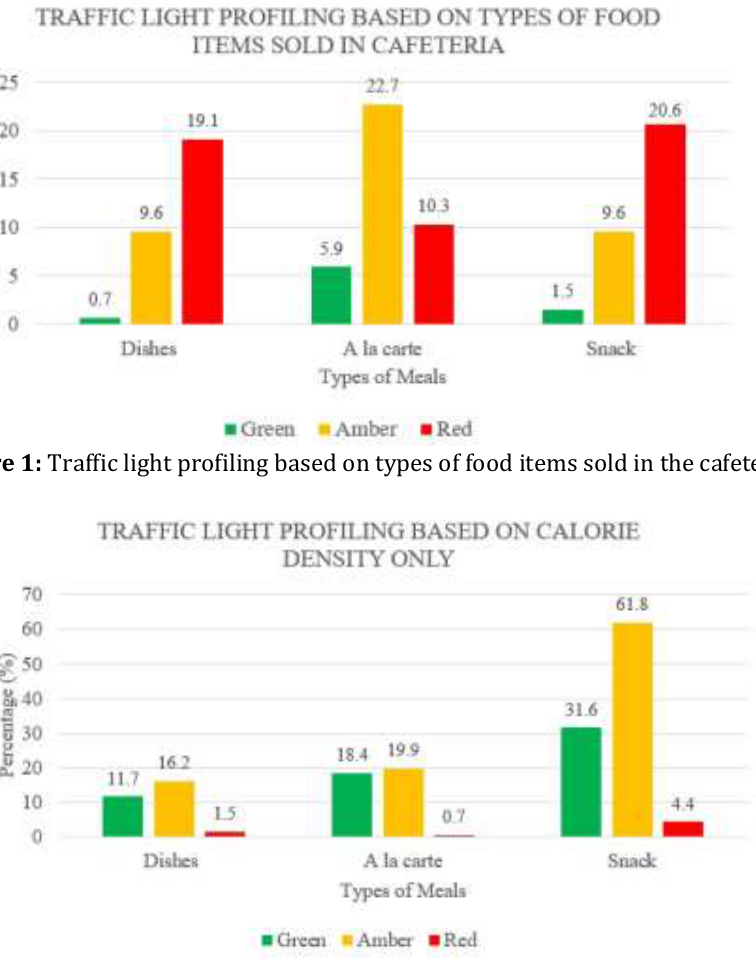
Figure 2 : Traffic light profiling for different meals sold in the cafeteria based on calorie density.